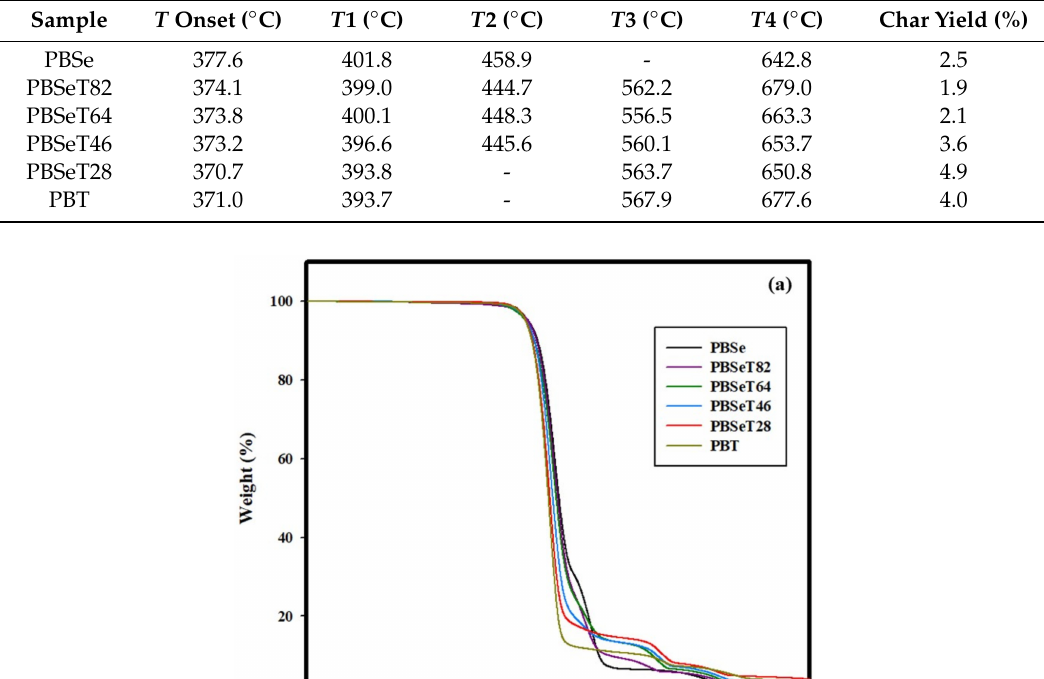
Table 4. TGA and DTGA data for the thermal decomposition of the synthesized copolyesters.